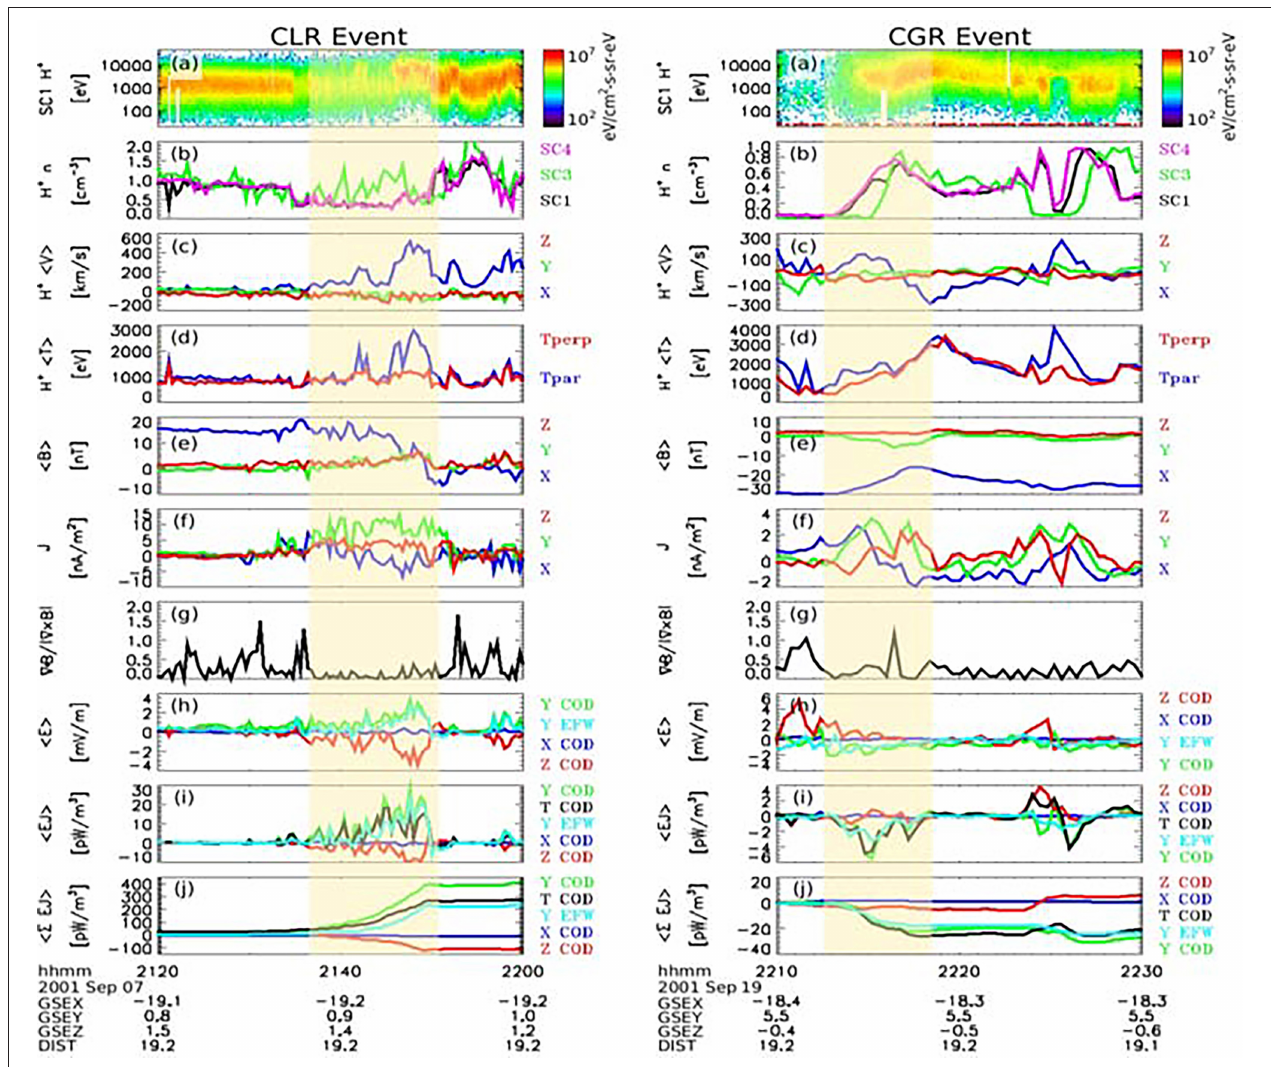
FIGURE 1 | Left: CLR Event, Right: CGR event—after (Marghitu et al., 2010).